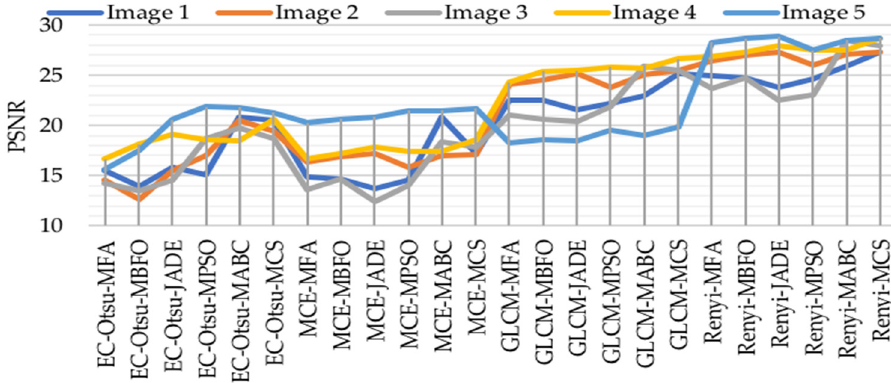
Figure 20. Results of PSNR values for all algorithms at level 8.